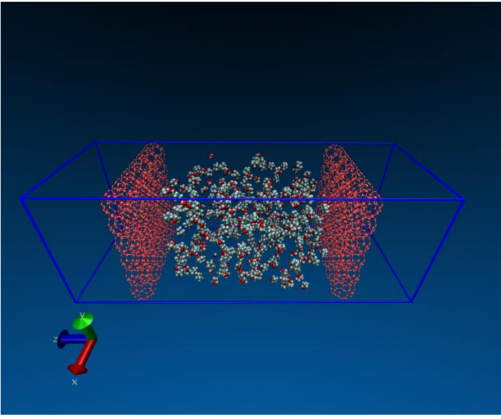
Figure 13. Schematic of the simulation system for vapor permeation through NaA zeolite membranes. Red represents the zeolite framework, water and iso-propyl alcohol (IPA) are between the two zeolite